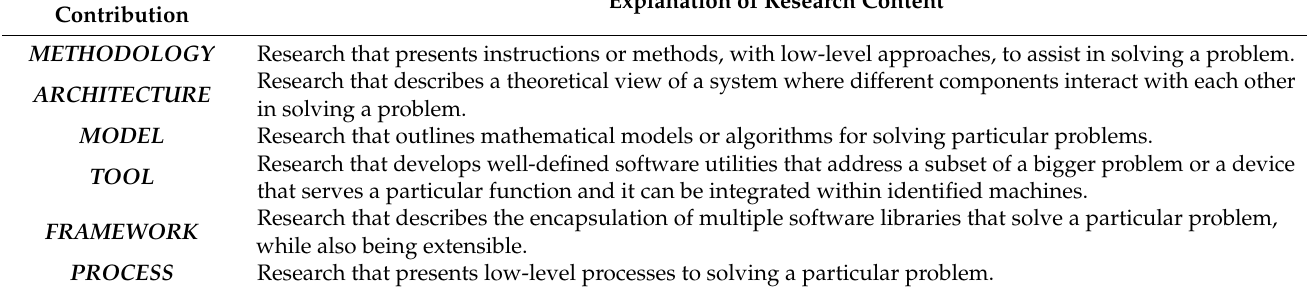
Table 4. Classification of type of contribution